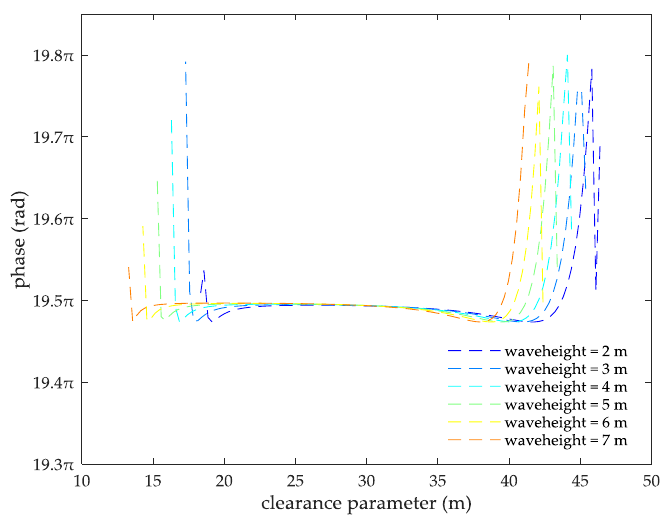
Figure 8. The ASFs of the AIS diffracted signal changing with the clearance parameters for different wave heights. Table 1. The corresponding data change table of Figure 9.